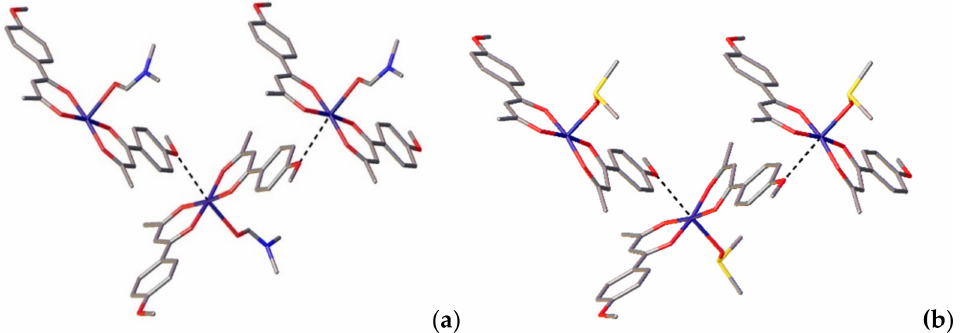
Figure 2. Crystal packing of 1 ( a ) and 3 ( b